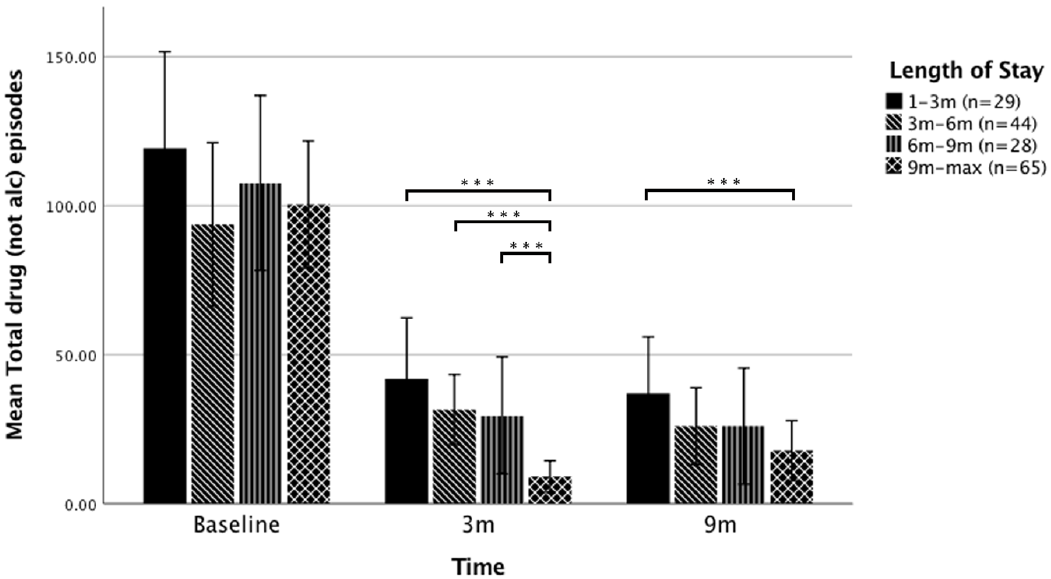
Figure 2. Mean number of drug episodes over the previous 90 days as a function of treatment duration at baseline, 3 months (3m) follow-up, and 9 months (9m) follow-up. Note, Error bars = 95% Confidence Interval of mean, *** p < 0.001, See Table S2 in Supplementary files for detailed statistics.